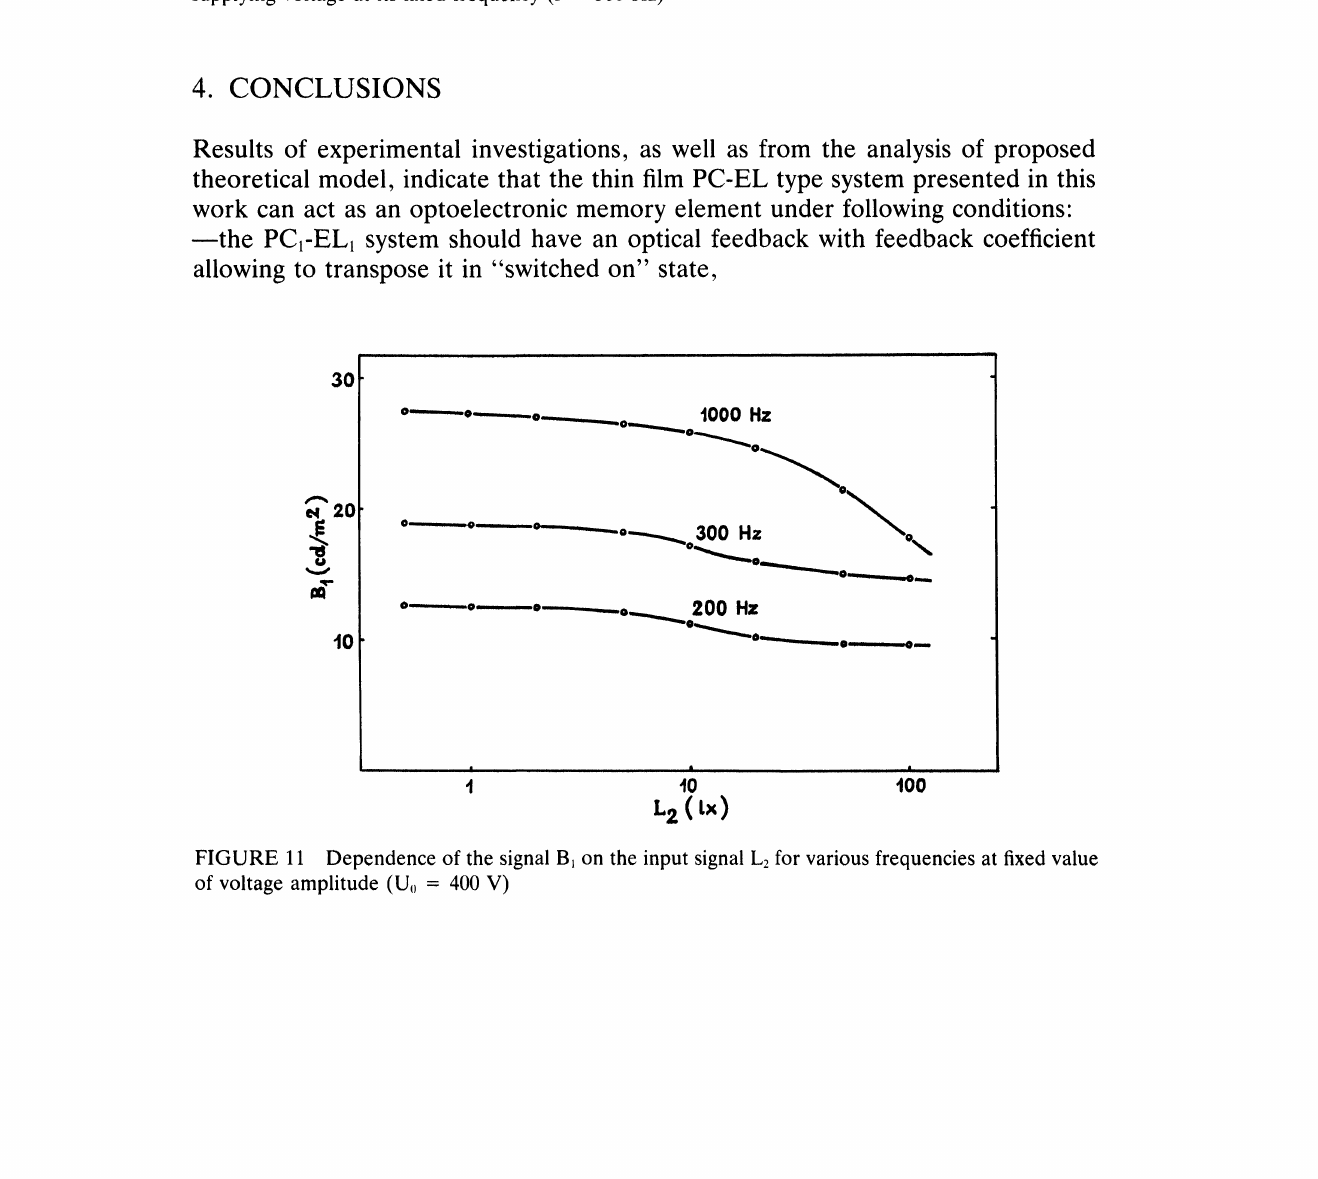
FIGURE 10 Dependence of the signal Bi on the input signal L2 for various values of amplitude of supplying voltage at its fixed frequency (f 300 Hz)